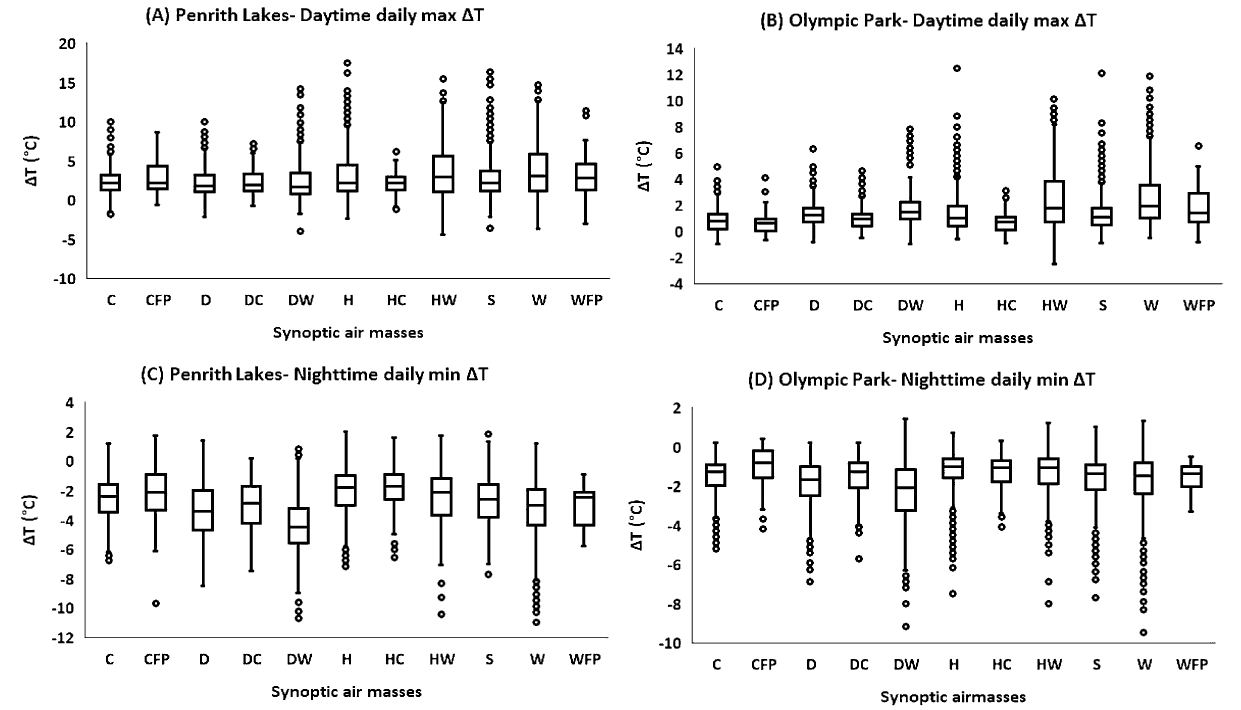
Figure 5. Daytime daily maximum ΔT and nighttime daily minimum ΔT at different Sydney sites under different synoptic air-masses. ( A) Daytime daily max ΔT at Penrith Lakes, ( B) Daytime daily max ΔT at Olympic Park, ( C) Nighttime daily minimum ΔT at Penrith Lakes, ( D) Nighttime daily minimum ΔT at Olympic Park. The boxplots are plotted according to the general convention (upper and lower extremes: Q1-1.5*IQR and Q3 +